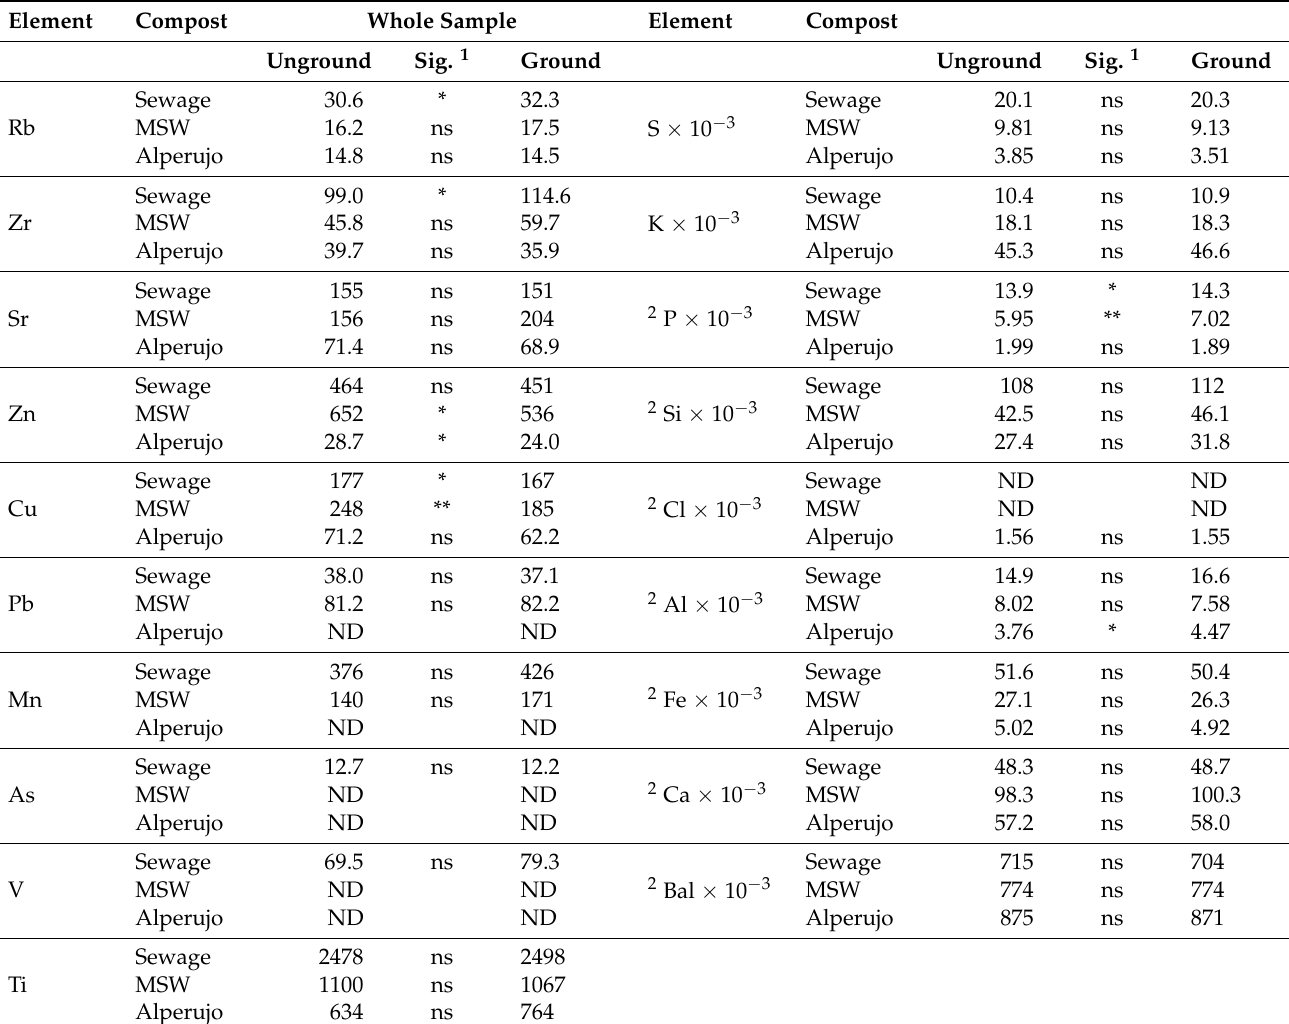
Table 4. Effect of sample grinding on the pXRF elemental readings in integral compost samples (comparison by t -test in three paired